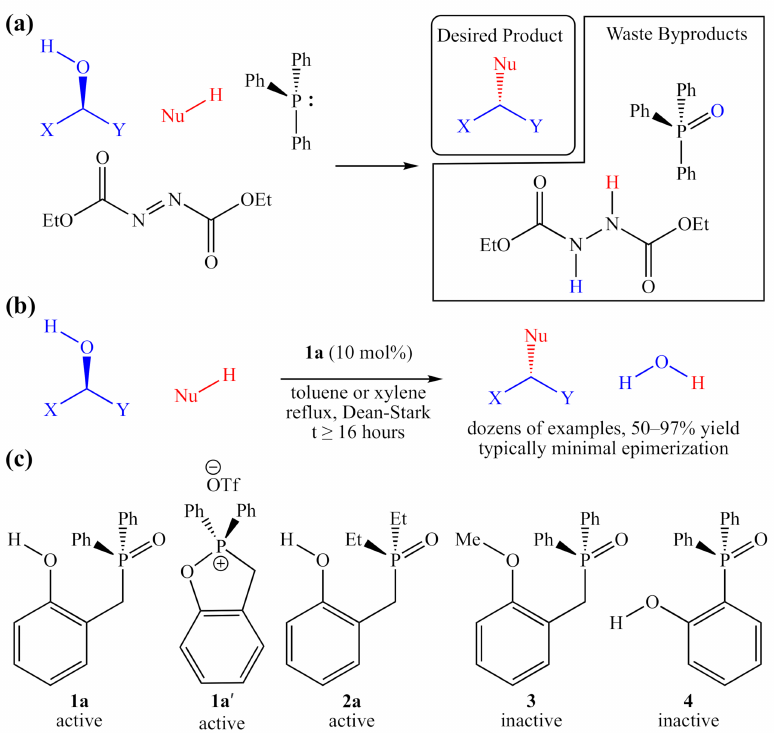
Figure 1. ( a ) A balanced generic traditional Mitsunobu reaction, using stoichiometric quantities of triphenylphosphine and diethyl diazodicarboxylate; ( b ) catalytic “Redox-Neutral” Mitsunobu reaction examined by Denton and co-workers; ( c ) active and inactive catalyst candidates examined by Denton and co-workers, and 2a , which is also